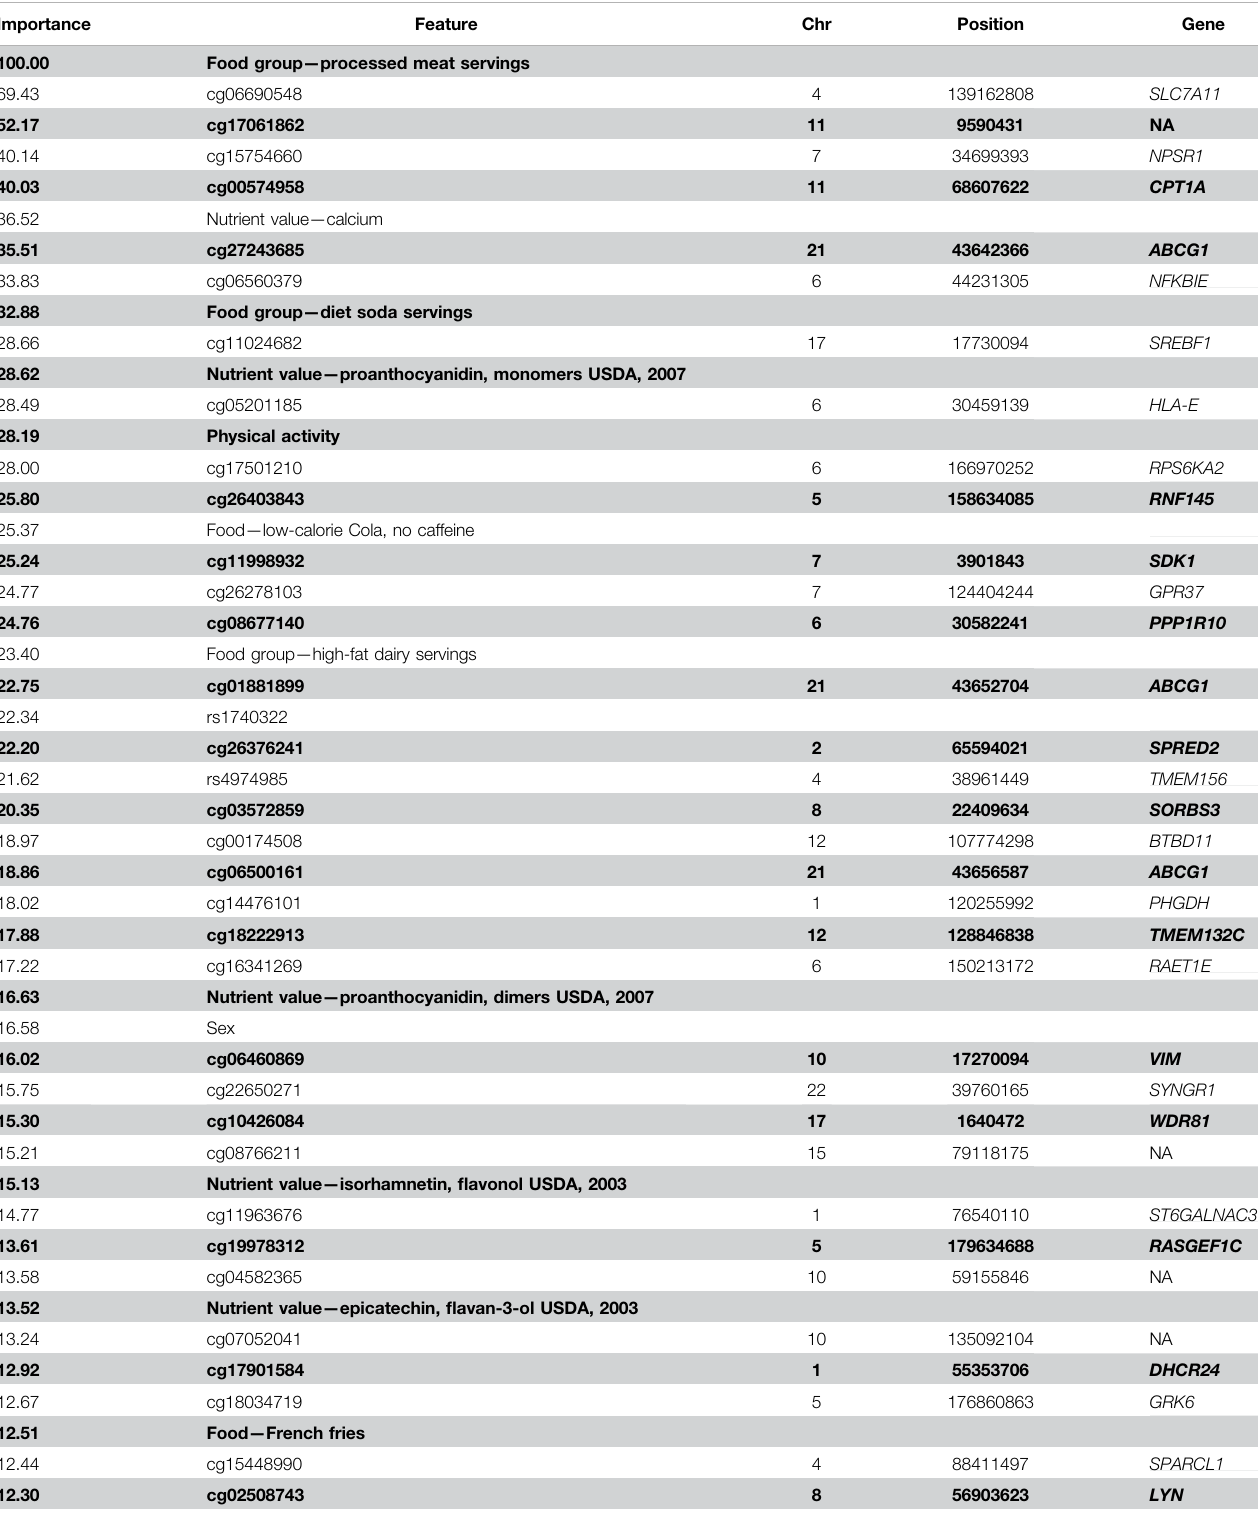
TABLE 3 | Top 50 predictive features of the best-performing model for predicting overweight/obesity status in the FOS.